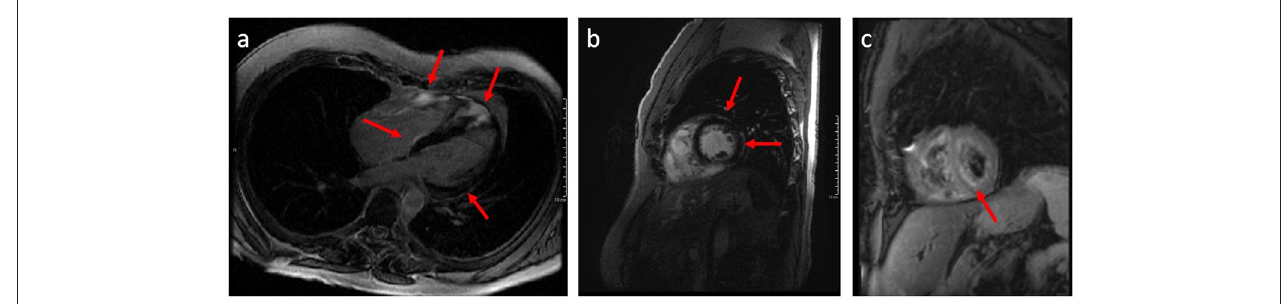
FIGURE 3 | Long axis (a) and short axis (b) CMR images demonstrating late gadolinium enhancement (LGE) having a patchy non-vascular midmyocardial and sub-epicardial pattern mainly involving the basal and apical septal wall, basal-mid lateral and anterior wall, and right ventricular wall; (c) Black blood T-2 weighted CMR images demonstrate patchy areas of predominantly midmyocardial increased signal intensity in the left and right ventricular myocardium denoting myocardial